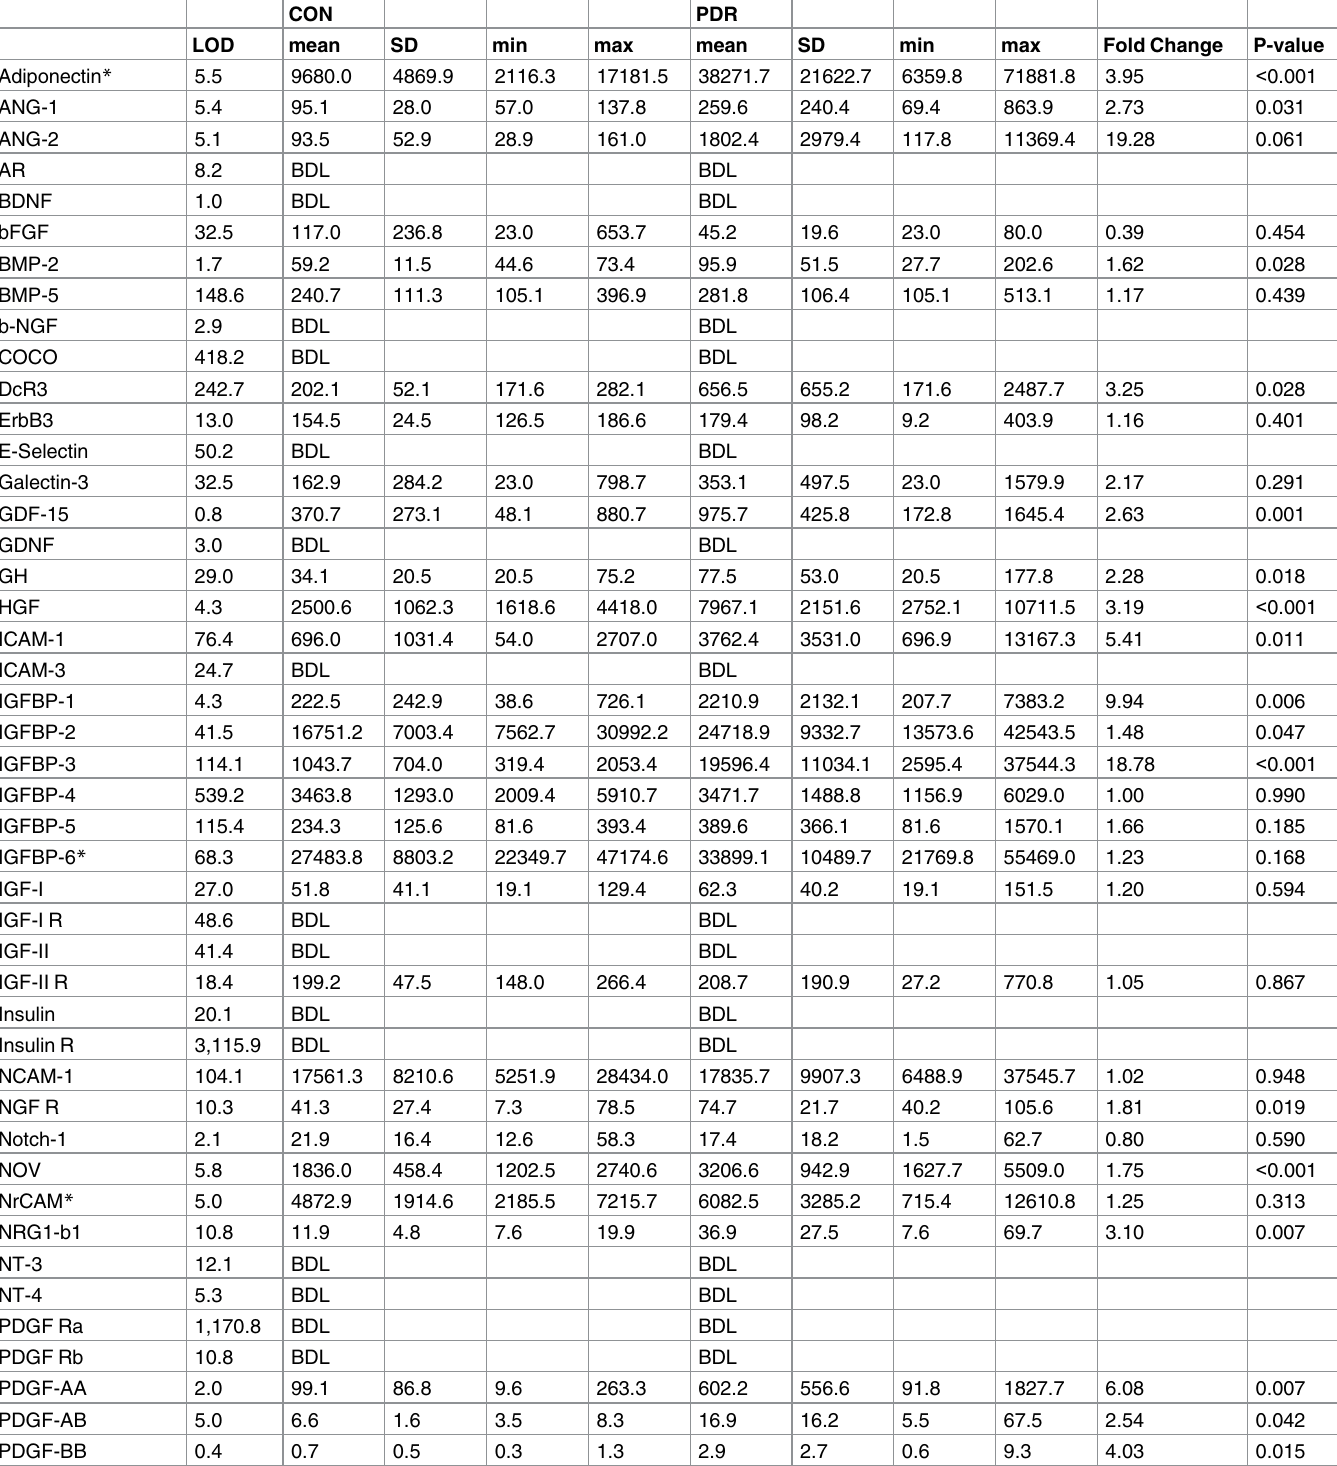
Table 3. Protein concentrations in vitreous of control and PDR patients. Protein concentrations were determined by Quantibodyarrays in patients with vitreal floaters (CON) and patients with proliferativediabeticretinopathy(PDR) that underwent vitreoretinal surgery. CON PDR LOD mean SD min max mean SD min max Fold